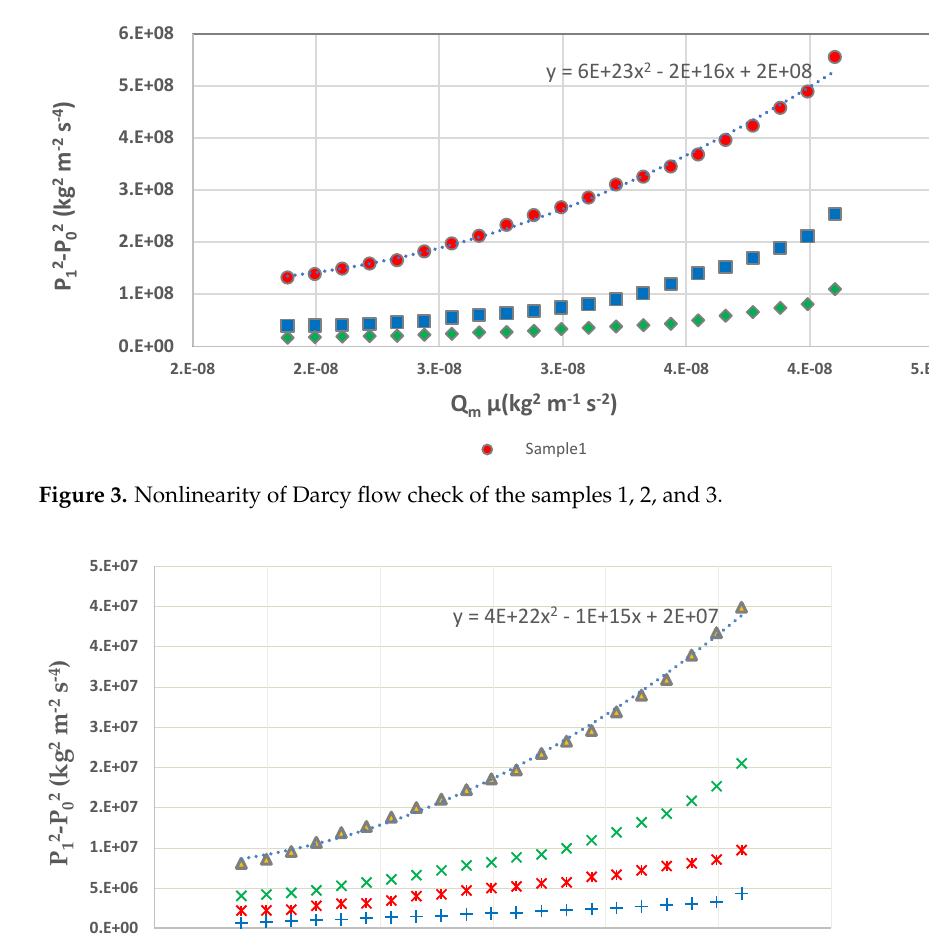
7 of 15 at the needed flow rate. The flow enters the sample radially Figure 2; the outlet is installed at the top of the sample perforation. The flow rate range was between 3 and 99 LPM; at each run, the pressure and flow data are converted to an Excel table and then later ana- lyzed. 4. Non-Darcy Flow Regime If Darcy’s law is considered assuming the air properties and k are constants and the term (𝑃 (cid:2870)(cid:2870) − 𝑃 (cid:2869)(cid:2870) ) plotted versus ( 𝑄𝑚 𝜇 ) would create a straight line. Figures 3 and 4 show the results of a test performed to check the nonlinearity of flow. By looking at Figures 3 and 4, the lines are not straight, and this indicates the presence of non-Darcy flow. In fact,